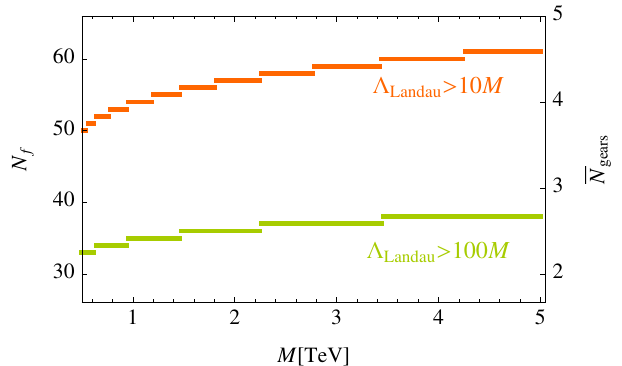
Figure 9 . Example upper bounds on the total number of colored Dirac fermions ( N f = 6+ N gears ) or, equivalently, on the e(cid:11)ective number of gears per quark (cid:13)avor ( (cid:22) N gears of the assumed common gear mass, M . Requiring there is no Landau pole in (cid:11) s below (cid:3) Landau = 10(100) M gives the bounds shown as orange (lower, green) lines, when rounding N f to the closest